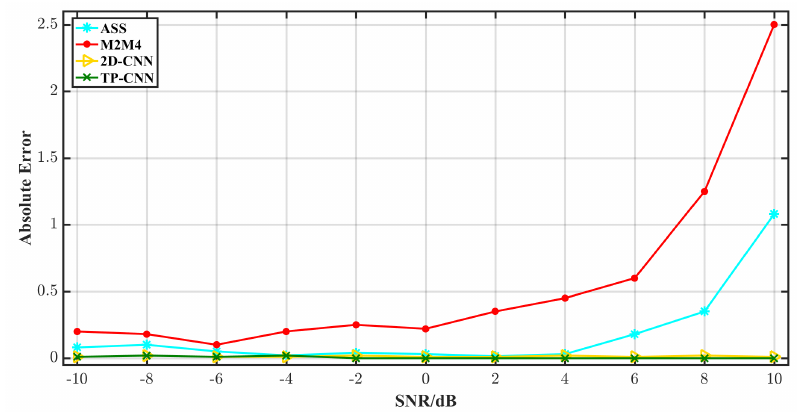
Figure 8. Absolute errors evaluated by the four algorithms at different